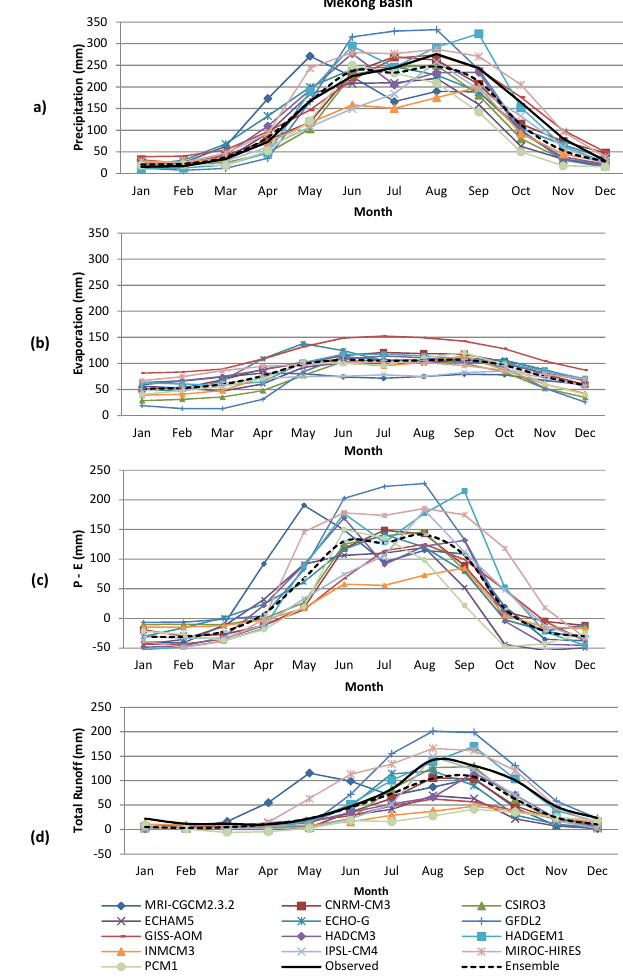
Fig. 4. 20th century annual cycles of considered quantities for the Brahmaputra Basin: (a) P , (b) E , (c) P − E , (d) R .